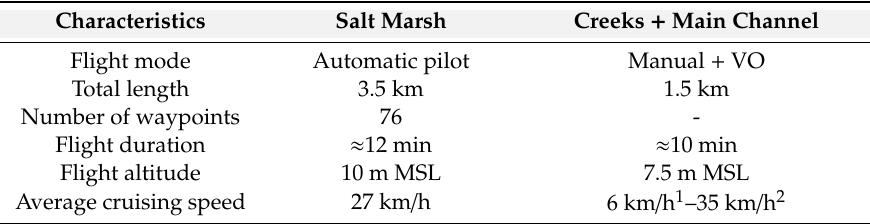
Table 2. Flight details for the first UAV, which releases the dye tracer over marshes, the main channel, and creeks.